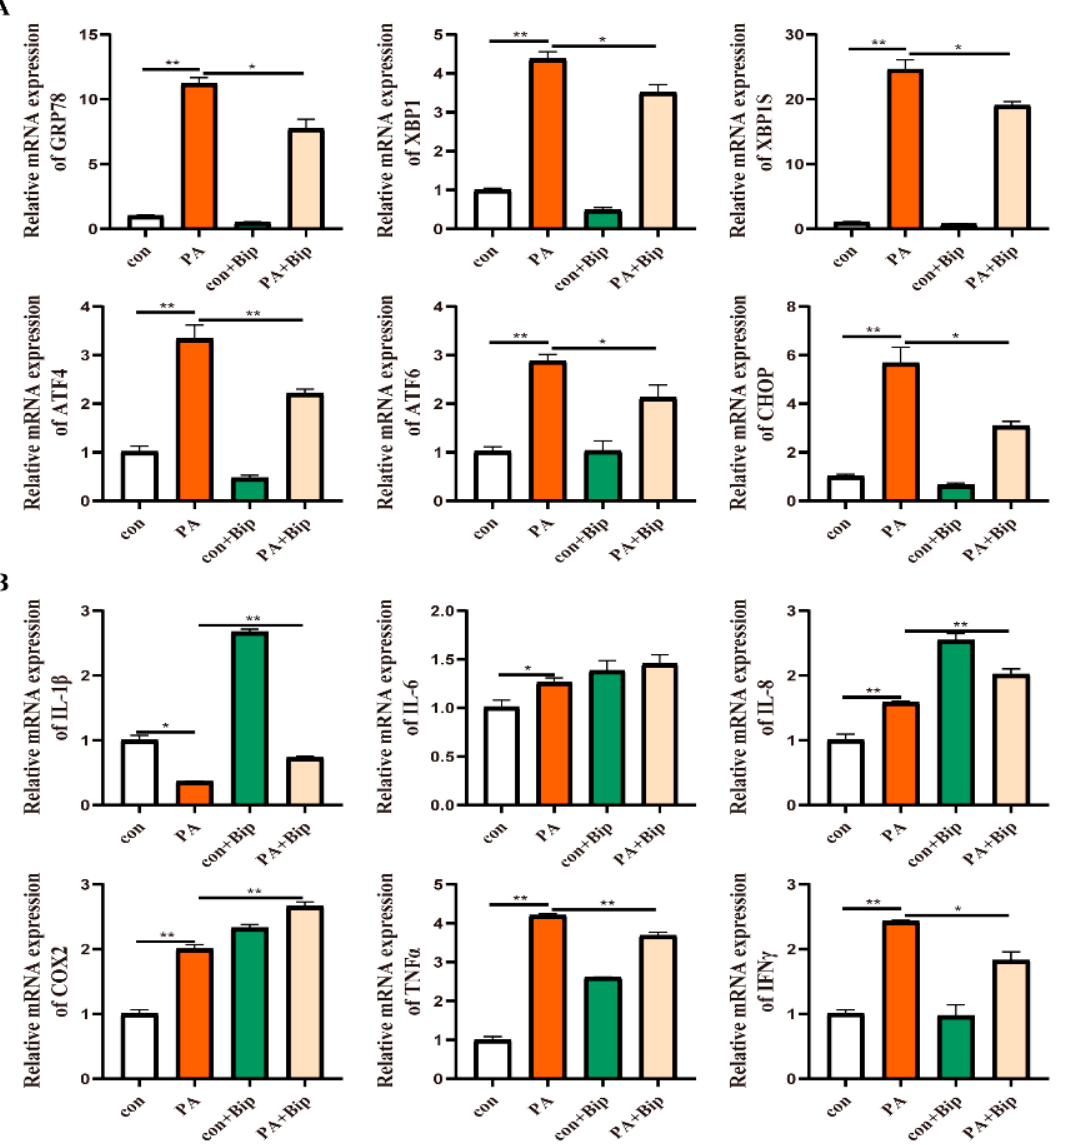
Figure 9. Effects of 10 µ M BiP treatment for 4 h before 500 µ M PA incubation for 6 h on ER stress and inflammation in macrophages of large yellow croakers. ( A ) Relative mRNA expression of ER stress-related genes. ( B ) Relative mRNA expression of inflammatory genes. Values are presented as mean ± SEM ( n = 3). * Significant difference ( p < 0.05); ** highly significant difference ( p <